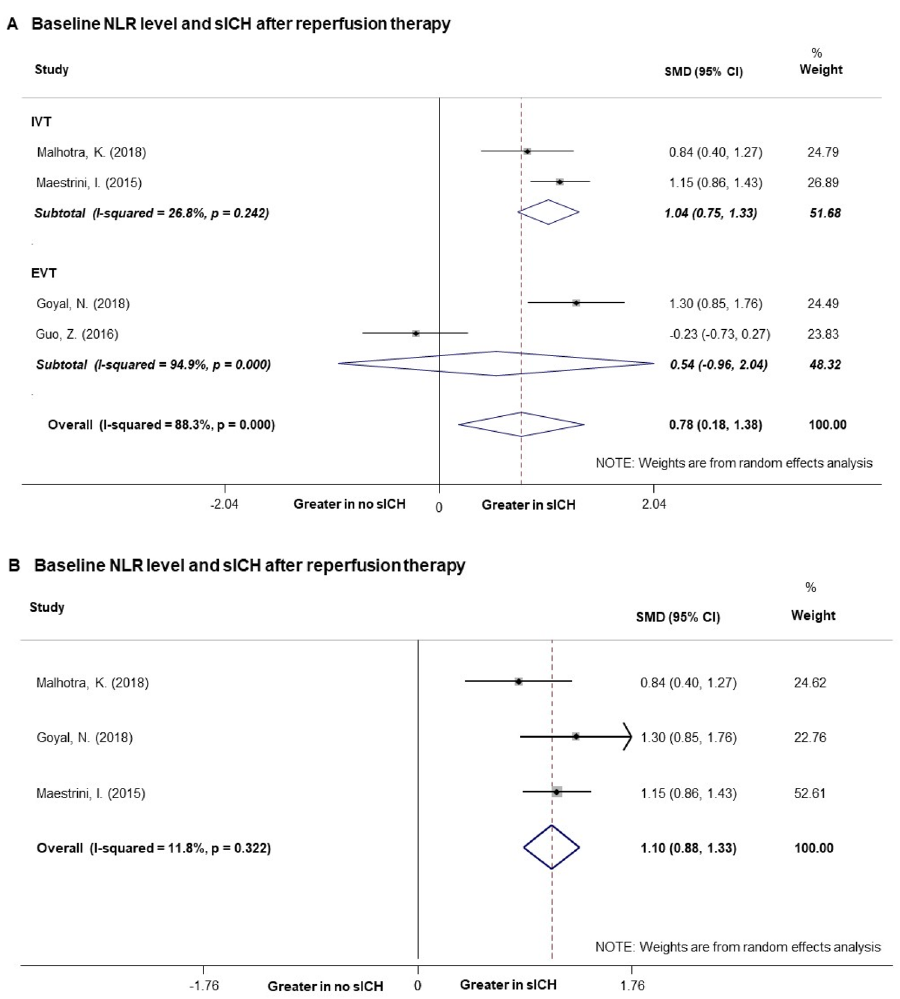
Figure 4. Forest plots of baseline NLR level and risk of early symptomatic intracerebral hemorrhage. ( A ) Pooled analysis of sICH after reperfusion therapy. ( B ) Pooled analysis of sICH after reperfusion therapy after excluding one study which brought high heterogeneity. NLR Neutrophil to lymphocyte ratio, sICH symptomatic intracerebral